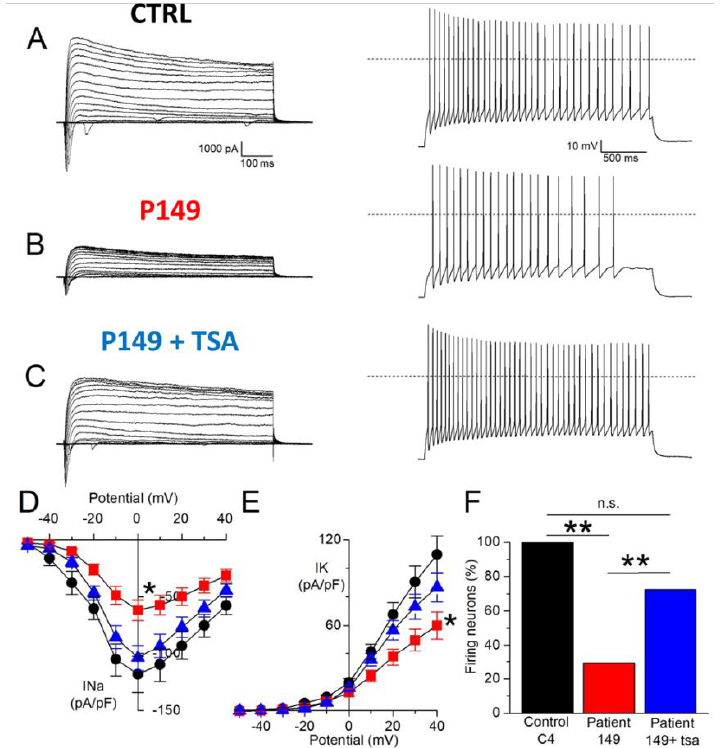
Figure 6. Electrophysiological characterization of neurons from control, P149, and P149 + TSA after 75 days of differentiation. ( A ) Left: representative total whole-cell ionic currents elicited in a control neuron with depolarizing voltage steps between − 70 and +60 mV, from a holding potential of − 70 mV; right, representative discharges of action potentials (APs) evoked with current-clamp recordings in a control neuron by the injection of a 2.5 s-long 50 pA depolarizing current step. ( B ) Similar representative recordings in a neuron from patient 149. ( C ) Similar representative recordings in a neuron from P149 + TSA. ( D ) I – V plot displaying the quantification of sodium current densities at different potentials for control (black circles), P149 (red squares), P149 + TSA (blue triangles): maximal current density for control C (118.4 ± 15.9 pA/pF, n = 12), P149 (61.4 ± 9.0 pA/pF, n = 24), and P149 + TSA (103.7 ± 11.4 pA/pF, n = 29); C vs. #149 p = 0.01, C vs. #149 + TSA p = 0.68, P149 vs. P149 + TSA p = 0.02 (ANOVA with Scheffe post-hoc test). ( E ) I – V plot displaying the quantification of potassium current densities at different potentials: maximal current density for control C (109.6 ± 13.0 pA/pF, n = 18), P149 (60.1 ± 9.5 pA/pF, n = 24), and P149 + TSAQ (86.8 ± 10.2 pA/pF, n = 30); C vs. P149 p = 0.01, C vs. P149 + TSA p = 0.35, P149 vs. P149 + TSA p = 0.19 (ANOVA with Scheffe post-hoc test). ( F ) quantification of the percentage of neurons able to generate at least one action potential for control C (13/13), P149 (7/24), P149 + TSA (21/29); C vs. P149 p < 0.001; C vs. P149 + TSA p = 0.25, P149 vs. P149 + TSA p = 0.007 (Fisher’s exact test with Bonferroni correction for multiple comparisons). * p < 0.05, ** p < 0.01, ns = not significant.